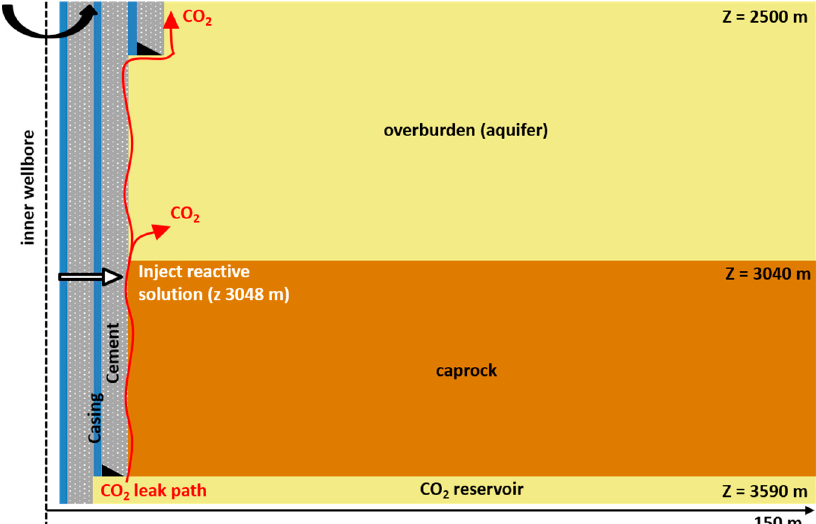
Figure 1. Schematic overview of the 2D radial symmetric TOUGHREACT model showing: the model dimensions, the different rock formations, the well and the leak path through the wellbore microannulus, and the location of leakage remediation.